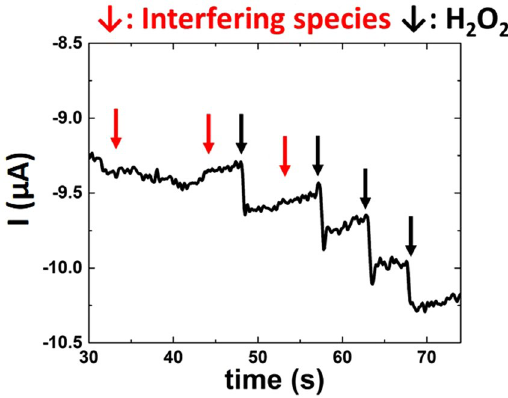
Figure 3. CNP3 CA with addition of interfering species and H 2 O 2 . Interfering species addition (200 μ M uric acid, glucose, or nitrite) causes no significant change in current. H 2 O 2 addition causes immediate response with each